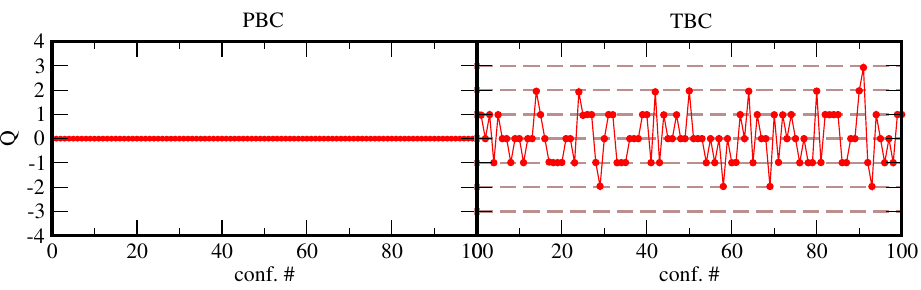
Figure 3 . Total topological charge ( Q ) on the PBC (left) and the TBC (right) lattices for each of 100